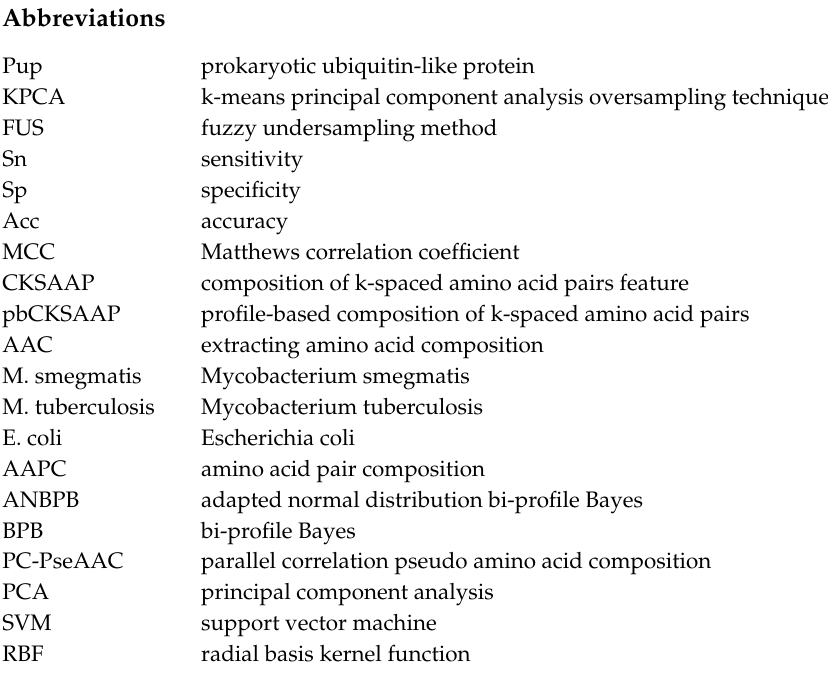
of SVM balance on the training dataset; Table S6: The prediction results of our method for the test dataset; Table S7: The prediction results of PUL-PUP for the test dataset; Table S8: The prediction results of PSoL for the test dataset; Table S9. The prediction results of SVM_balance for the test